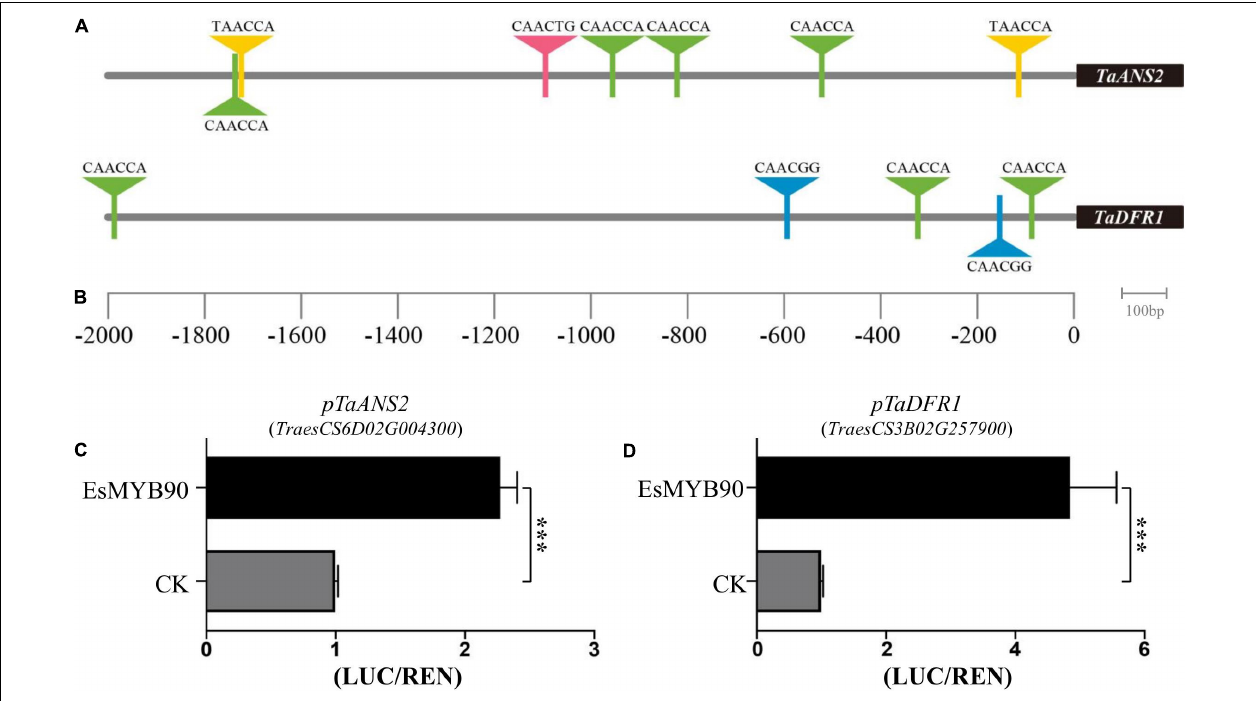
FIGURE 9 | EsMYB90 activates the transcription of flavonoid biosynthesis genes in transgenic wheat. (A) MYB-binding motifs analysis in TaANS2 promoter region. (B) MYB-binding motifs analysis in TaDFR1 promoter region. (A,B) The triangle indicates the predicted MYB recognized cis -elements. (C) Relative luciferase activity (LUC/REN) of TaANS2 promoter ( pTaANS2 ) by EsMYB90. (D) Relative luciferase activity (LUC/REN) of TaDFR1 promoter ( pTaDFR1 ) by EsMYB90. The values are means ± SD of three biological replicates. Asterisks indicate significant difference: *** p ≤ 0.001.